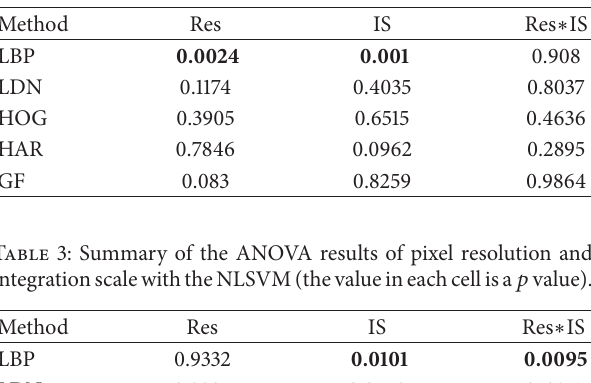
Table 2: Summary of the ANOVA results of pixel resolution and integration scale with the LSVM (the value in each cell is a 𝑝 value).